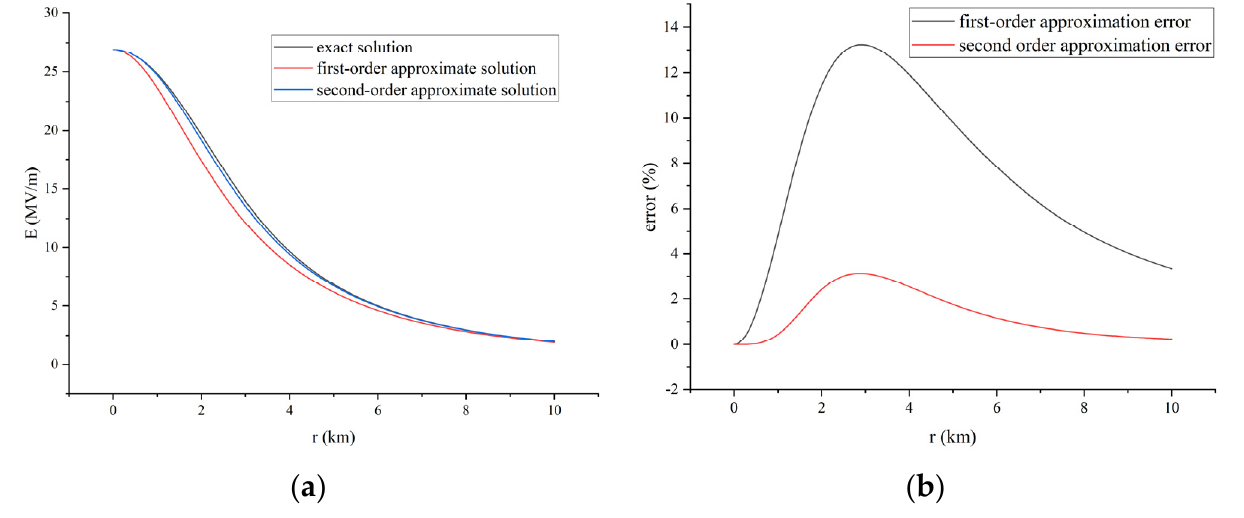
Figure 3. ( a ) Comparison of the first-order approximate solution, second-order approximate solution and exact solution while z = 5 km. ( b ) Relative error of first-order approximation and second-order approximation while z = 5 km.